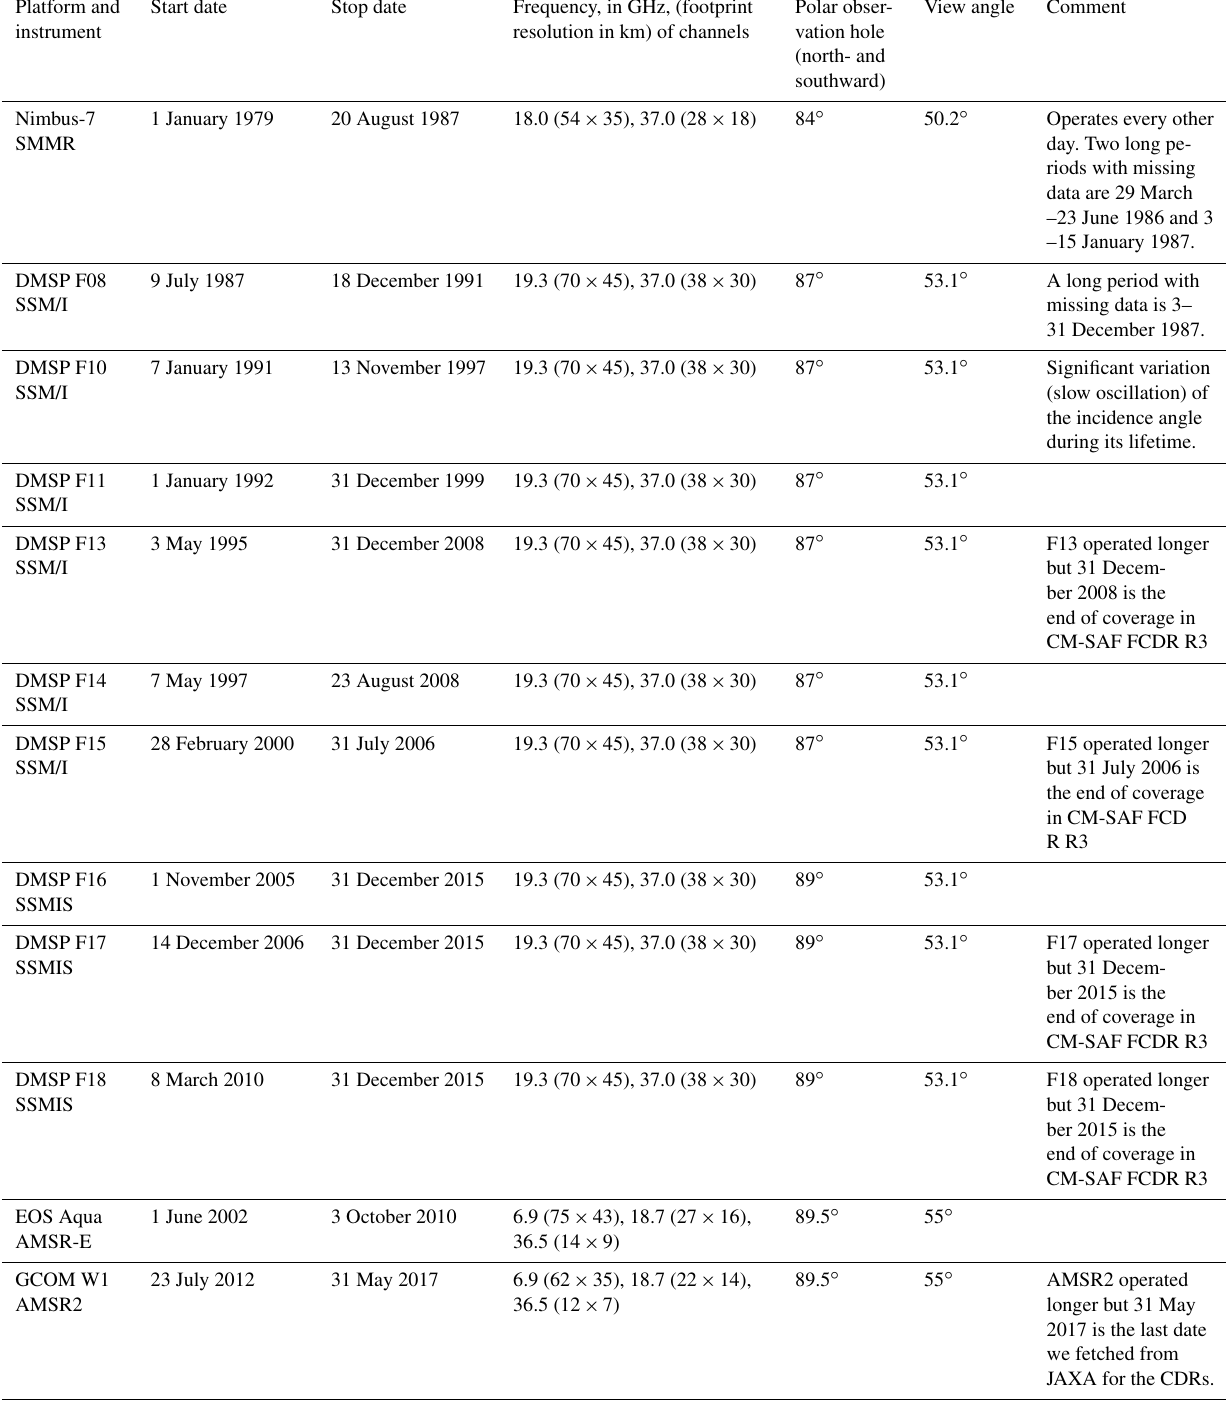
Table 2. Platform, instrument, and time period for input brightness temperatures used in the sea-ice data records. All frequencies listed have both horizontal and vertical polarization